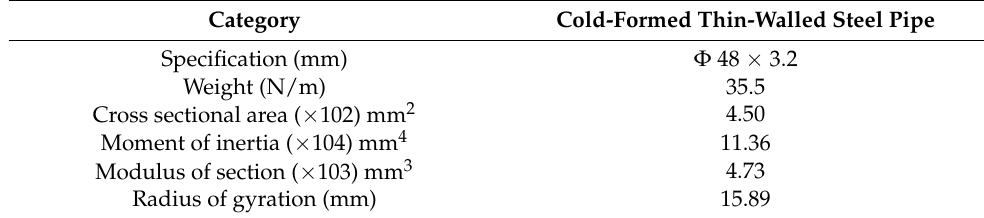
Table 1. Section characteristics of steel pipe of support